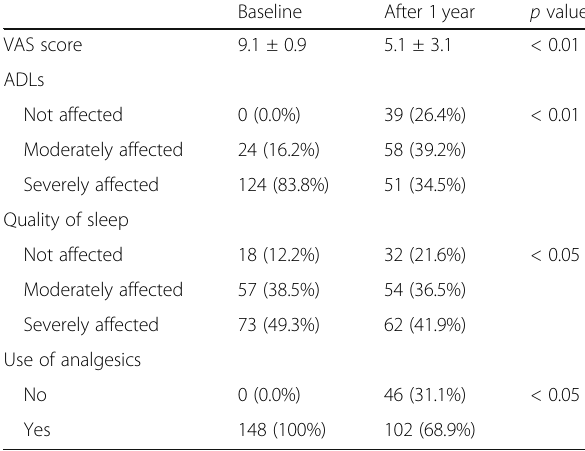
Table 1 Outcome measures before and after epiduroscopy Baseline